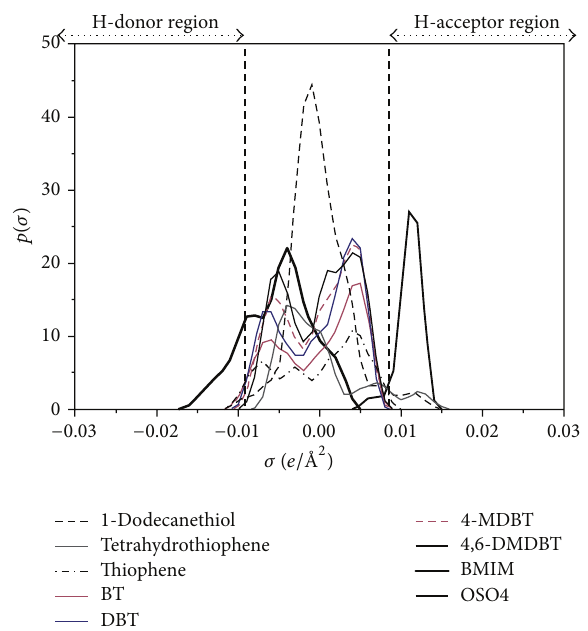
Figure 2: Sigma profile for [BMIM][OSO 4 ] and respective sulfur species.